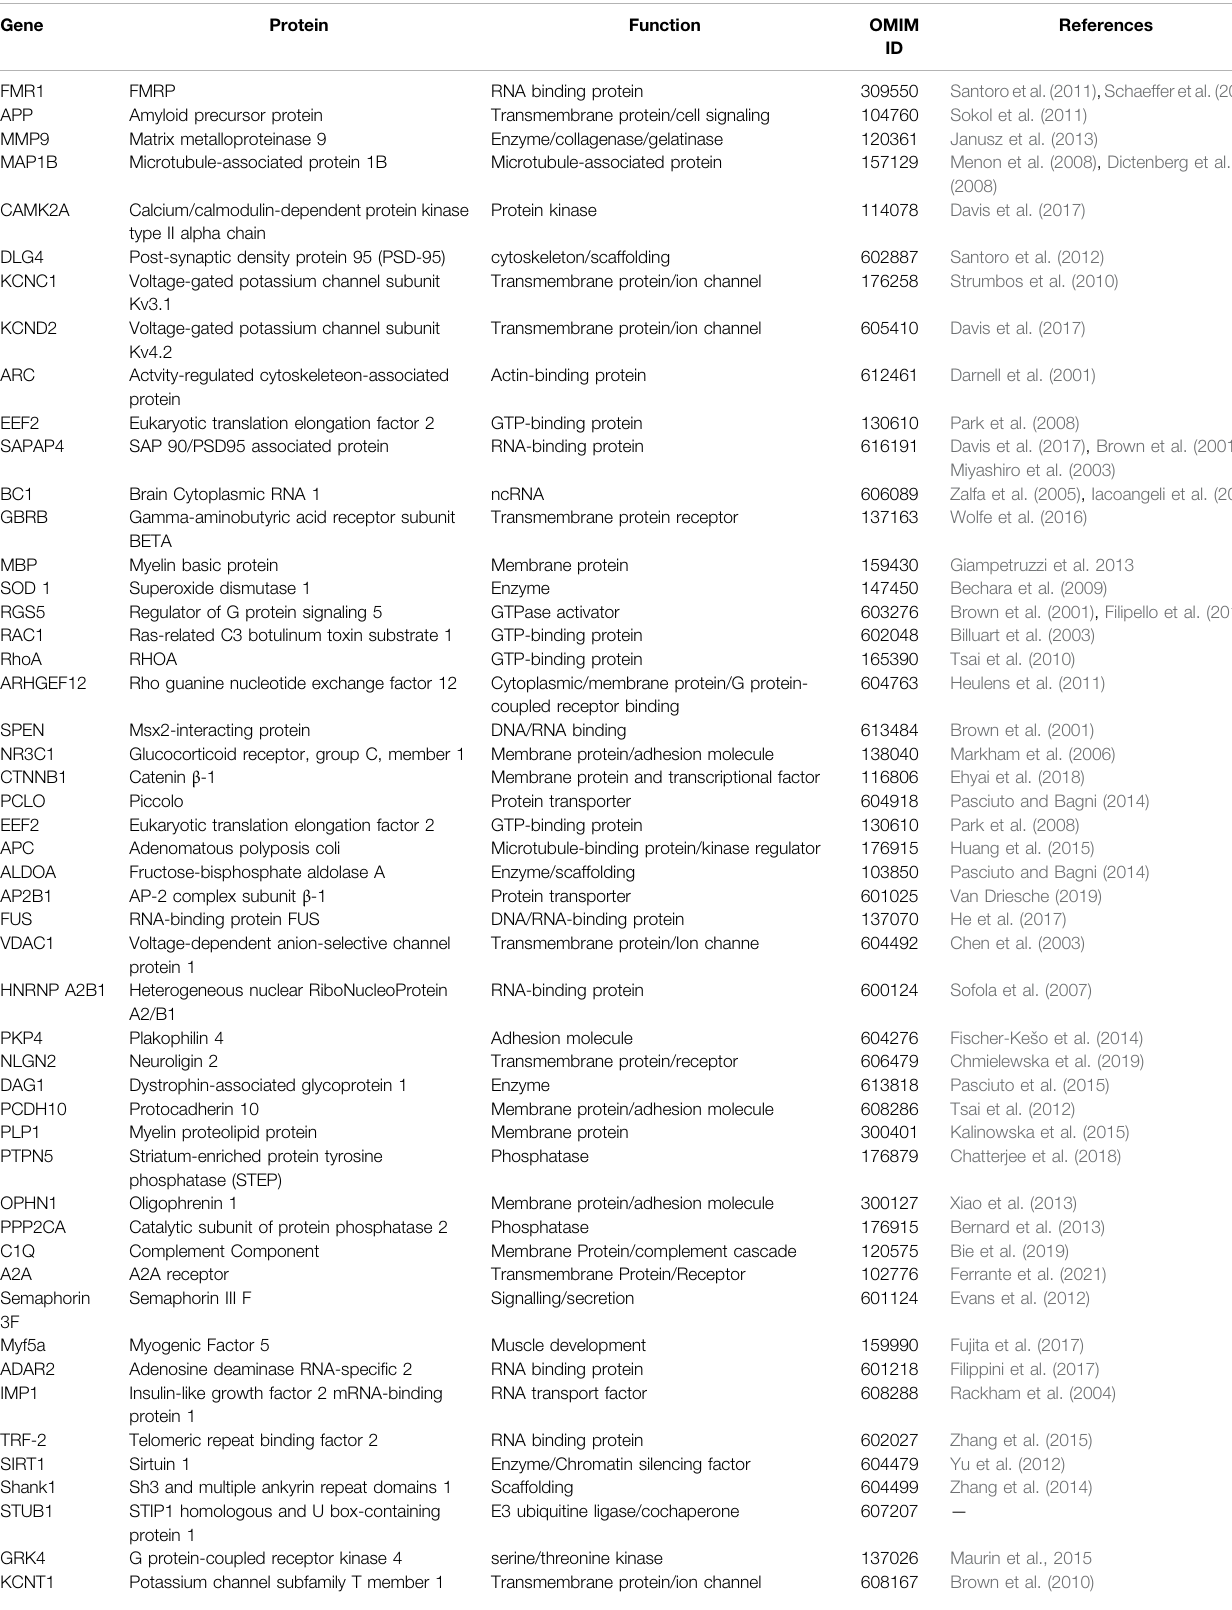
TABLE 2 | FMRP mRNAs